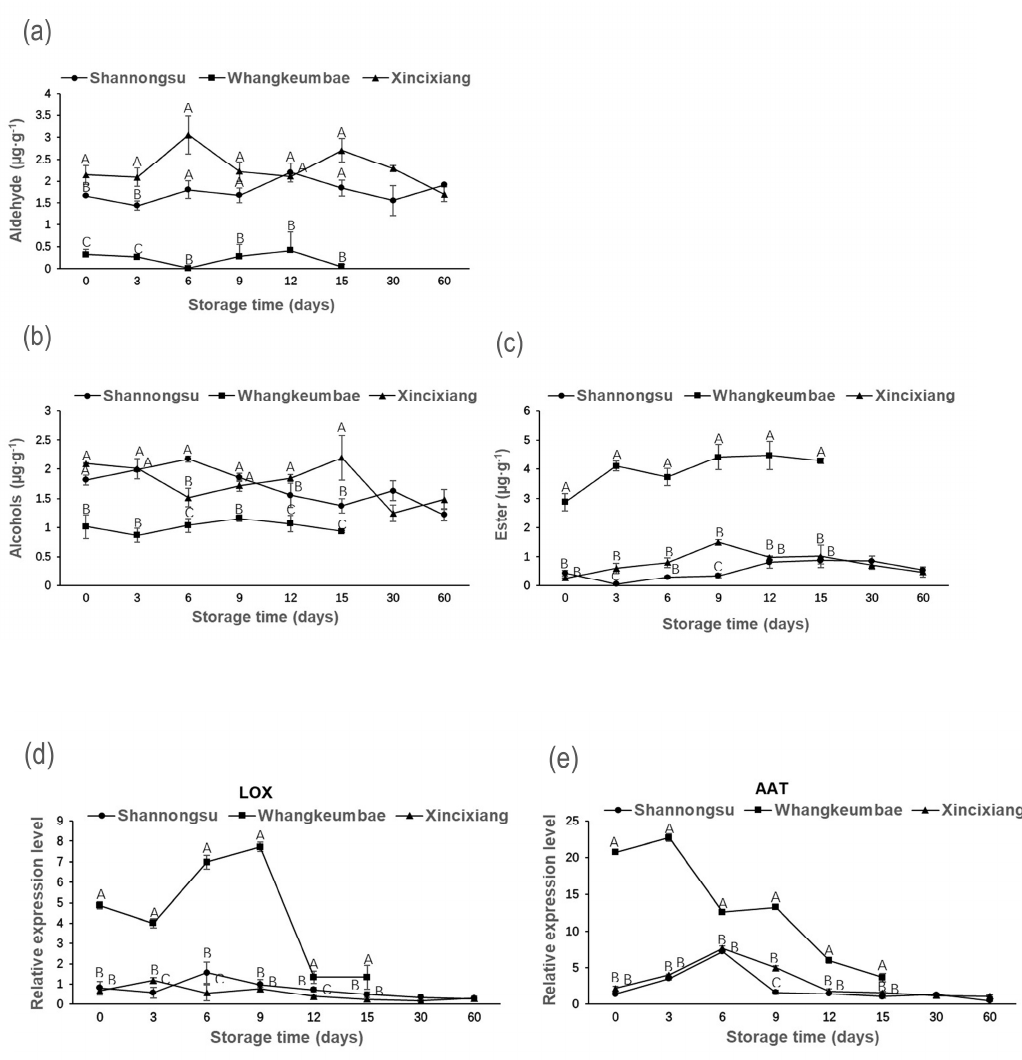
Figure 4. The contents of aroma volatile and expression of key genes related to aroma. ( a – c ) Compo- nents of aroma; ( d , e ) expression of key genes related to aroma production. Values shown represent means ± SD (n = 3). Different letters indicate significant differences between treatments ( p ≤ 0.01).